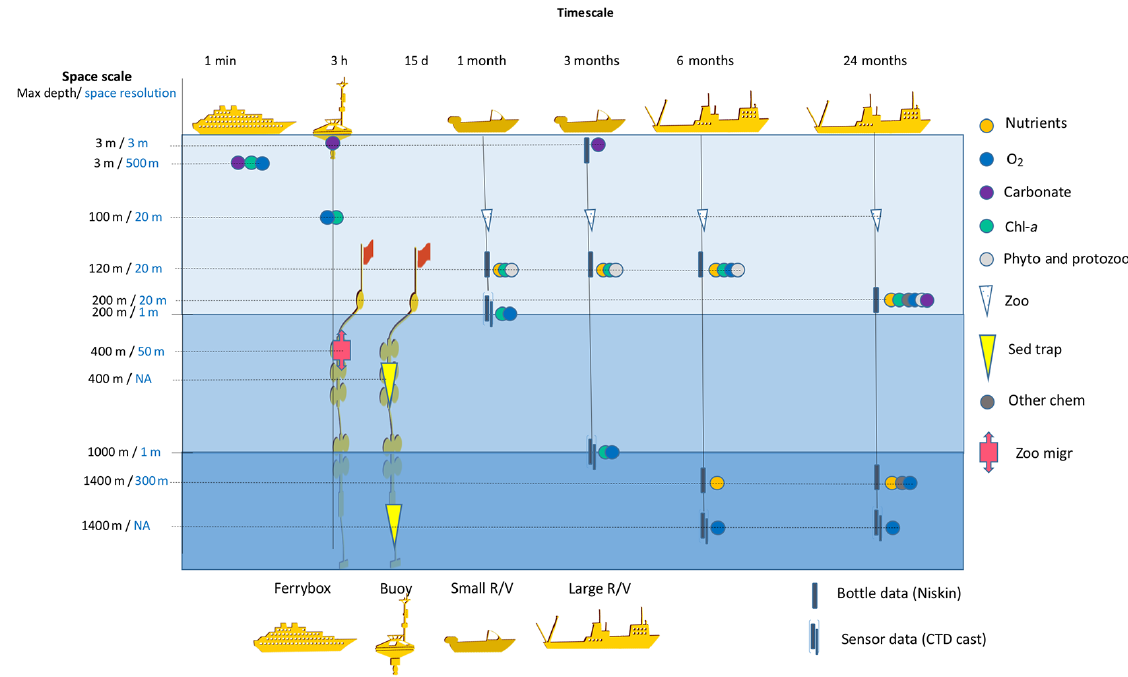
Figure 10. Time and space resolution of biogeochemical data acquisition by the different platforms of the observatory. The list of variables can be found in Tables 1–3. Space resolution is vertical except in the case of Ferrybox. Carbonate: pH, p CO 2 or C T and A T ; other chem: other chemical variables; sed trap: sediment trap; phyto and protozoo: phytoplankton and protozoans; zoo: metazoans (collected with nets); zoo migr: ADCP backscatter data for zooplankton migration.